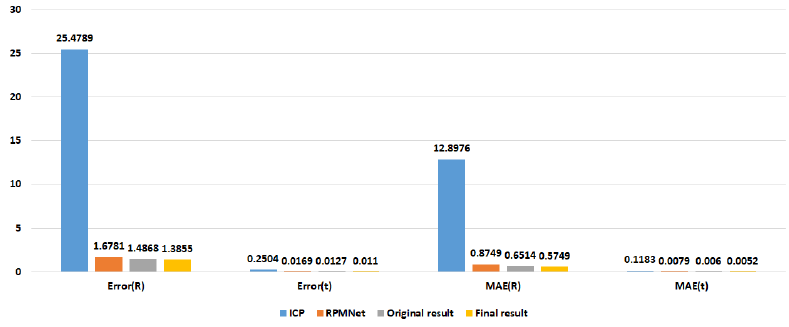
Figure 11. Registration results on ModelNet40.